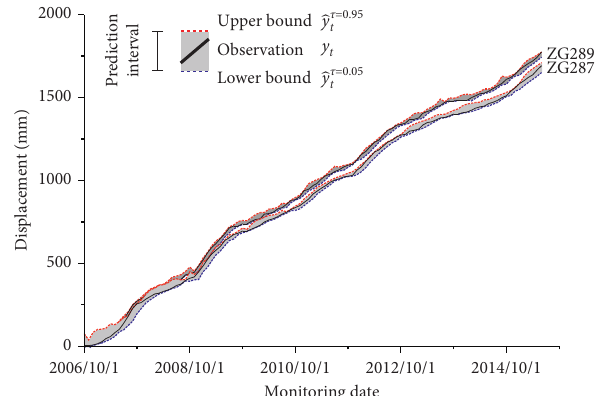
Figure 10: PIs with a nominal confidence level of 90% for landslide displacement obtained using the polynomial KSVMQR.